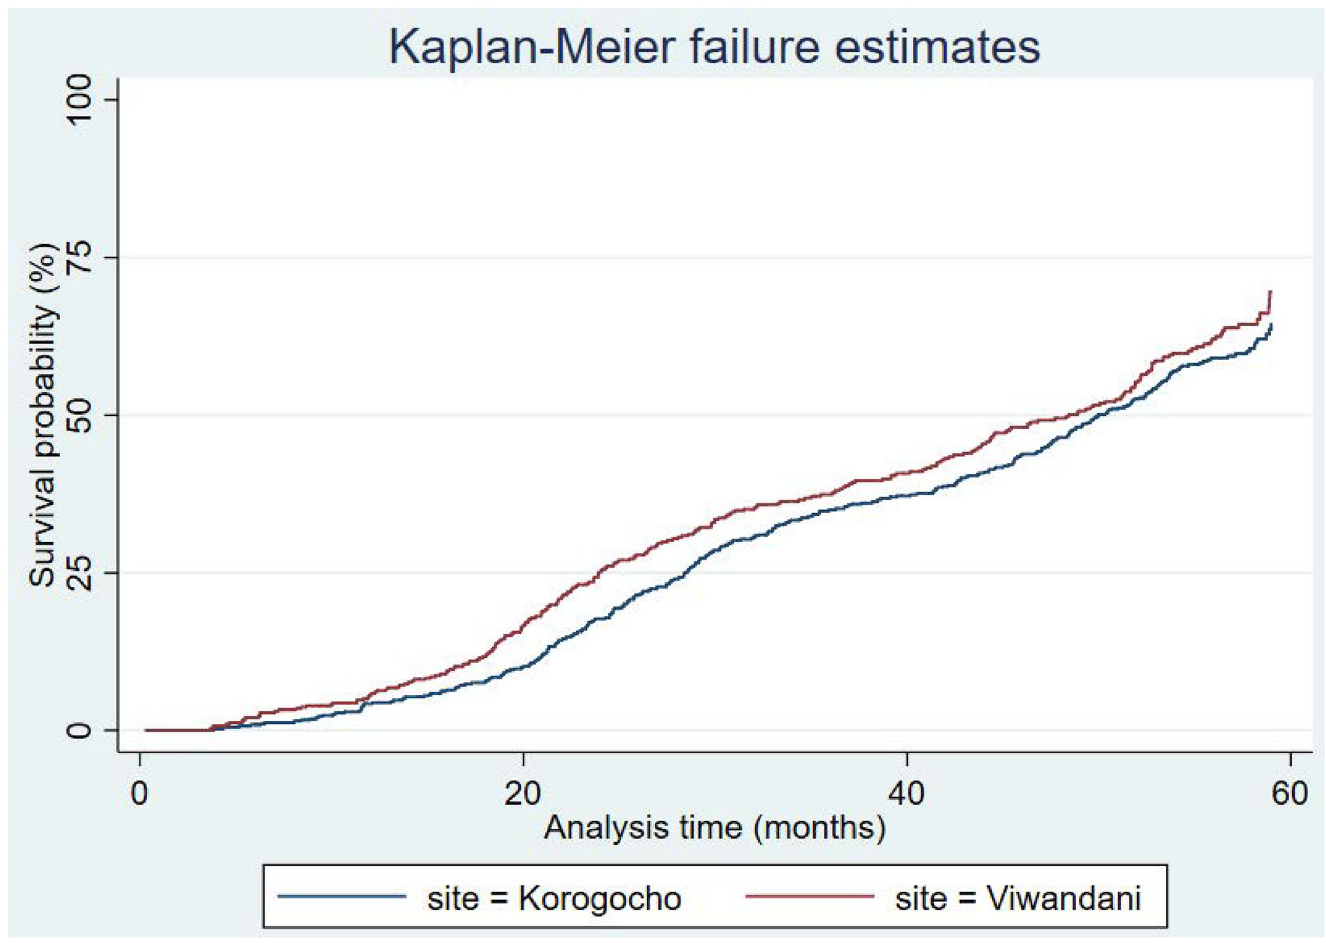
Fig 4. Kaplan-Meier recovery estimates by